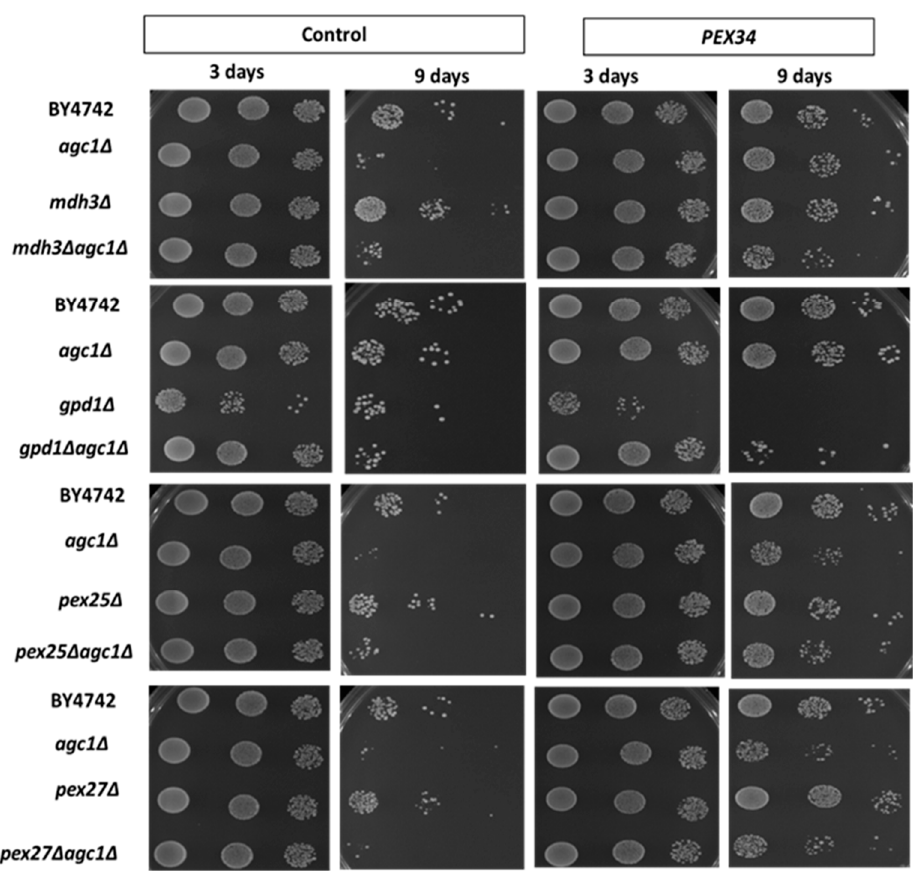
Figure 4. PEX34 -mediated longevity requires peroxisomal genes for NAD + regeneration, but not for peroxisome proliferation. Yeasts lacking genes involved in NAD + regeneration in the peroxisome ( MDH3 , GPD1 ) and peroxisome proliferation ( PEX25 , PEX27 ) were tested for chronological longevity under PEX34 over-expression. The yeast array on an SD plate supplemented with 2% glucose indicated viability starting with 10 5 , 10 4 , and 10 3 cells. Note that PEX34 -mediated longevity requires GPD1 expression and loss of GPD1 decreased the longevity at the early stationary phase.